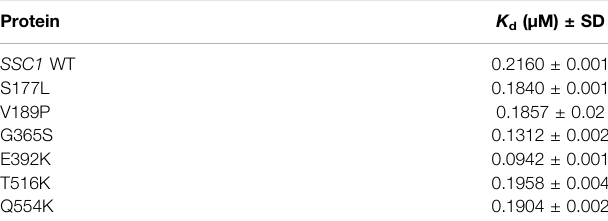
TABLE 4 | List of the equilibrium dissociation constants ( K d ) for F-P5 for yeast Ssc1 CSA-variants proteins. Protein